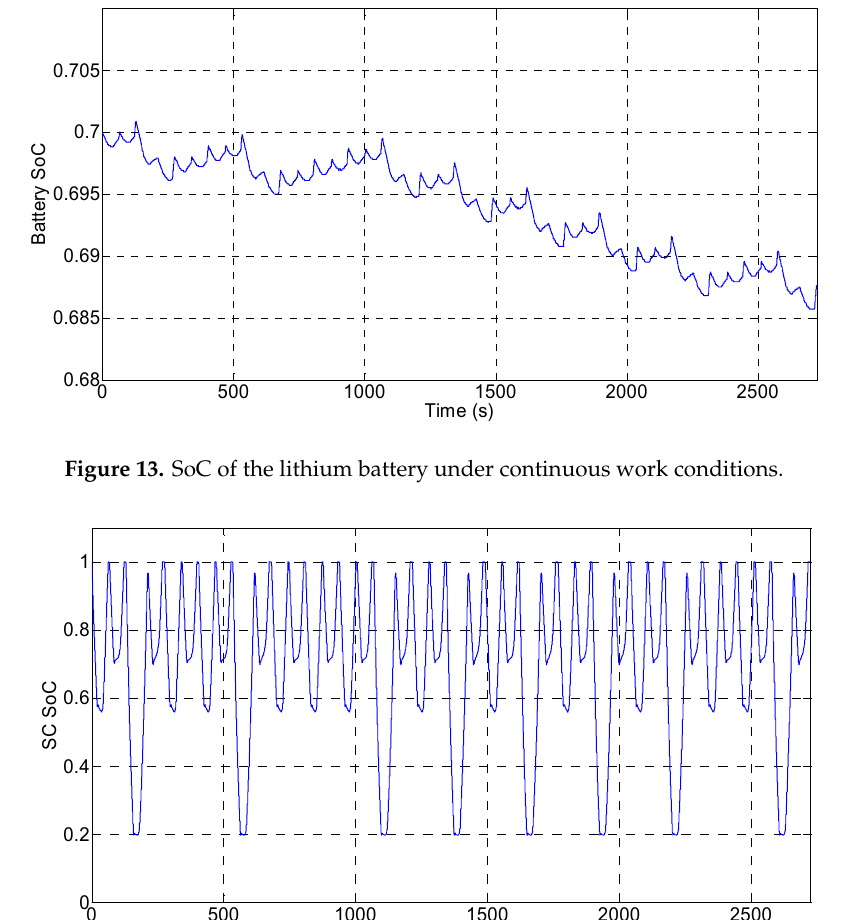
Figure 14. SoC of the SC under continuous work conditions.